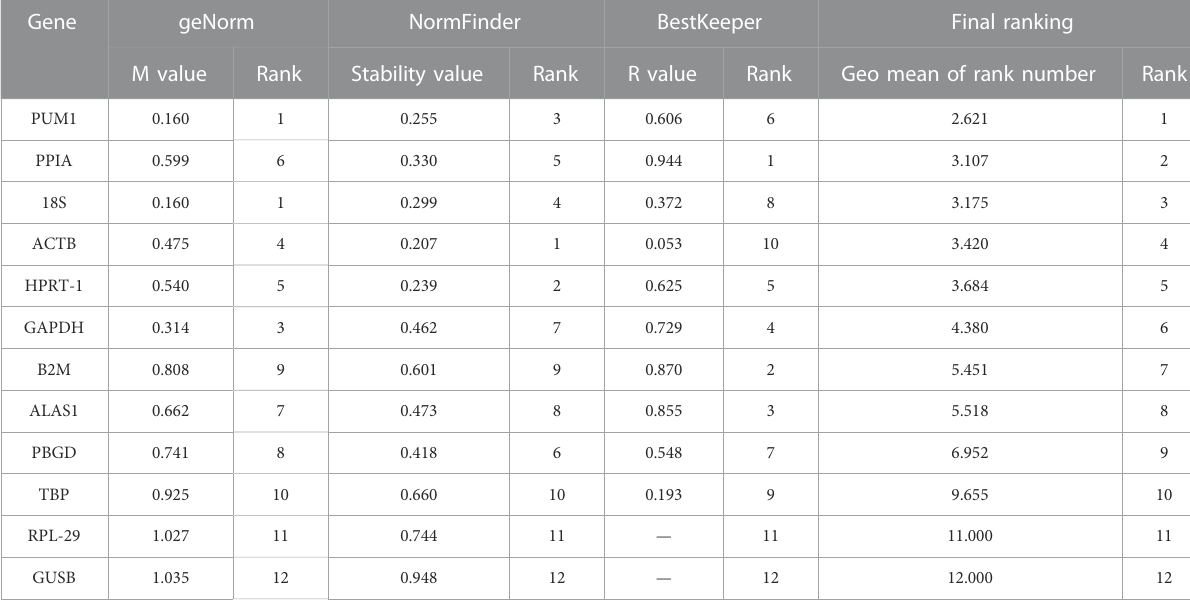
TABLE 2 Overall ranking of the candidate reference genes ’ stability.